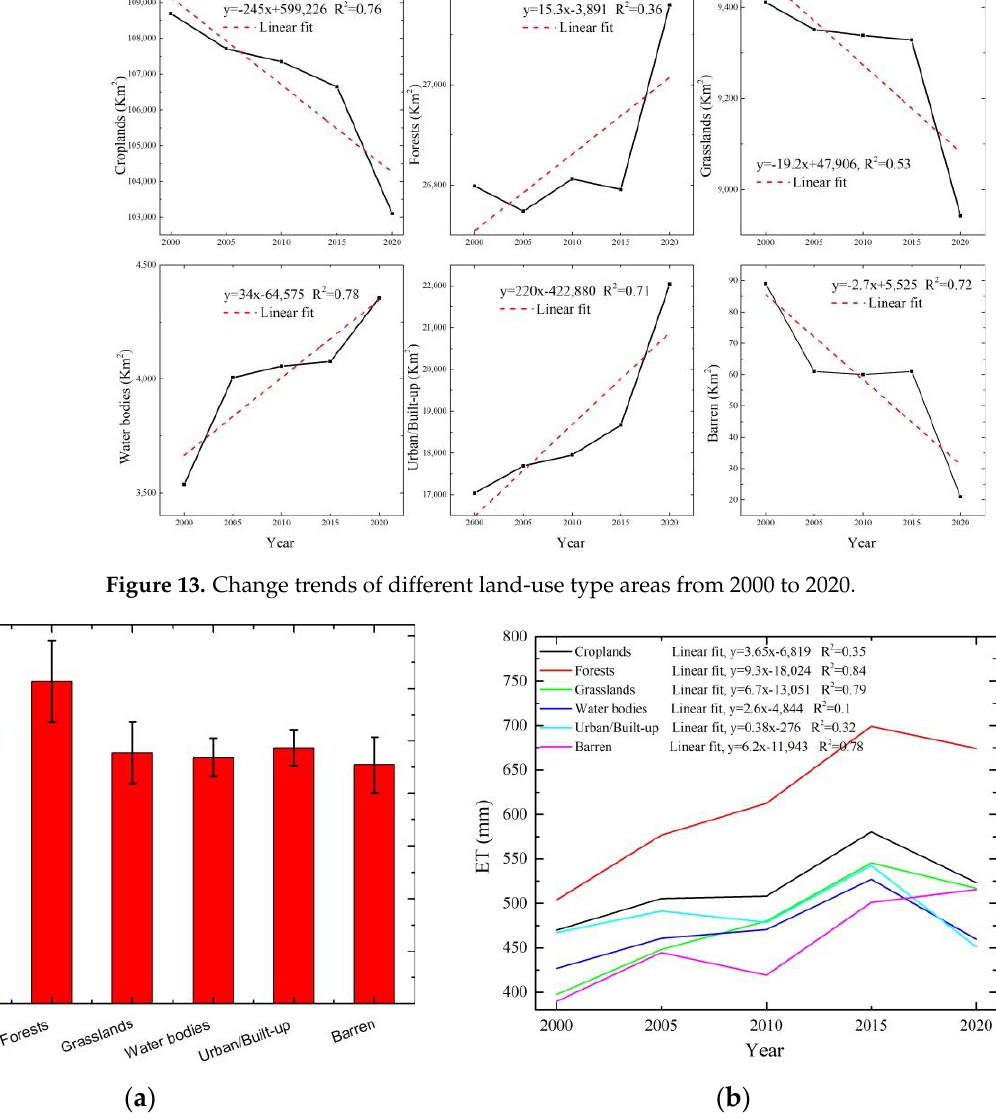
Figure 14. Annual average ET of different land-uses types ( a ) and the annual ET variations of different land-use types from 2000 to 2020 ( b ).